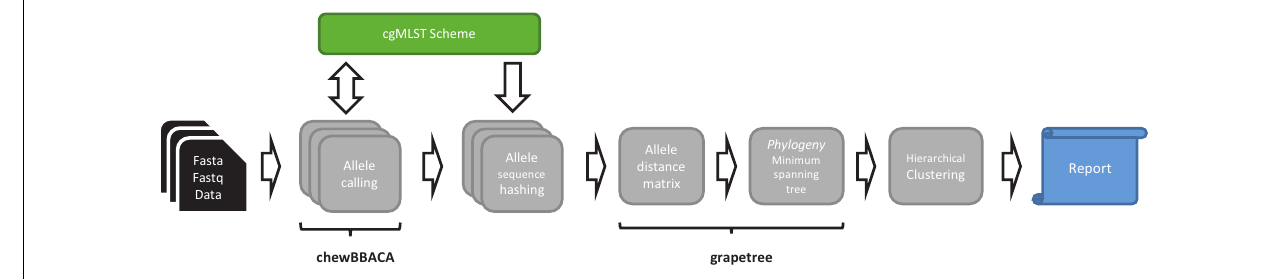
FIGURE 1 | Schematic representation of the chewieSnake workflow. The workflow starts from a set of assemblies (fasta data) or a set of raw reads (fastq data), which are then assembled into fasta files. On these, cgMLST allele calling is performed using the tool chewBBACA, utilizing a designated cgMLST scheme, to which newly found alleles are added in the process. The resulting allele profiles are converted to hashed allele profiles. All profiles are subsequently combined; and an allele distance matrix and a minimum-spanning tree phylogeny are computed with the tool GrapeTree. Then, cluster types are generated by hierarchical clustering at different allele distance thresholds. Finally, the results are summarized in an interactive HTML